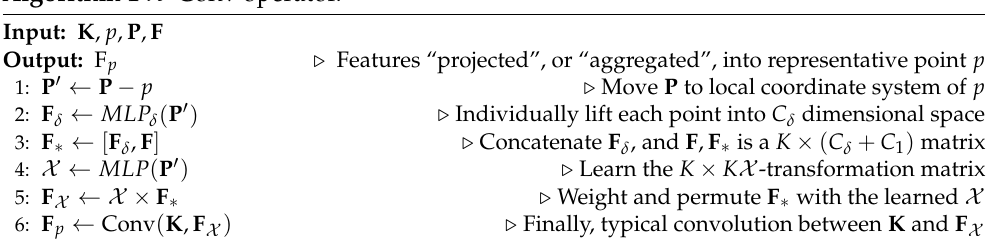
Algorithm 1 X -Conv